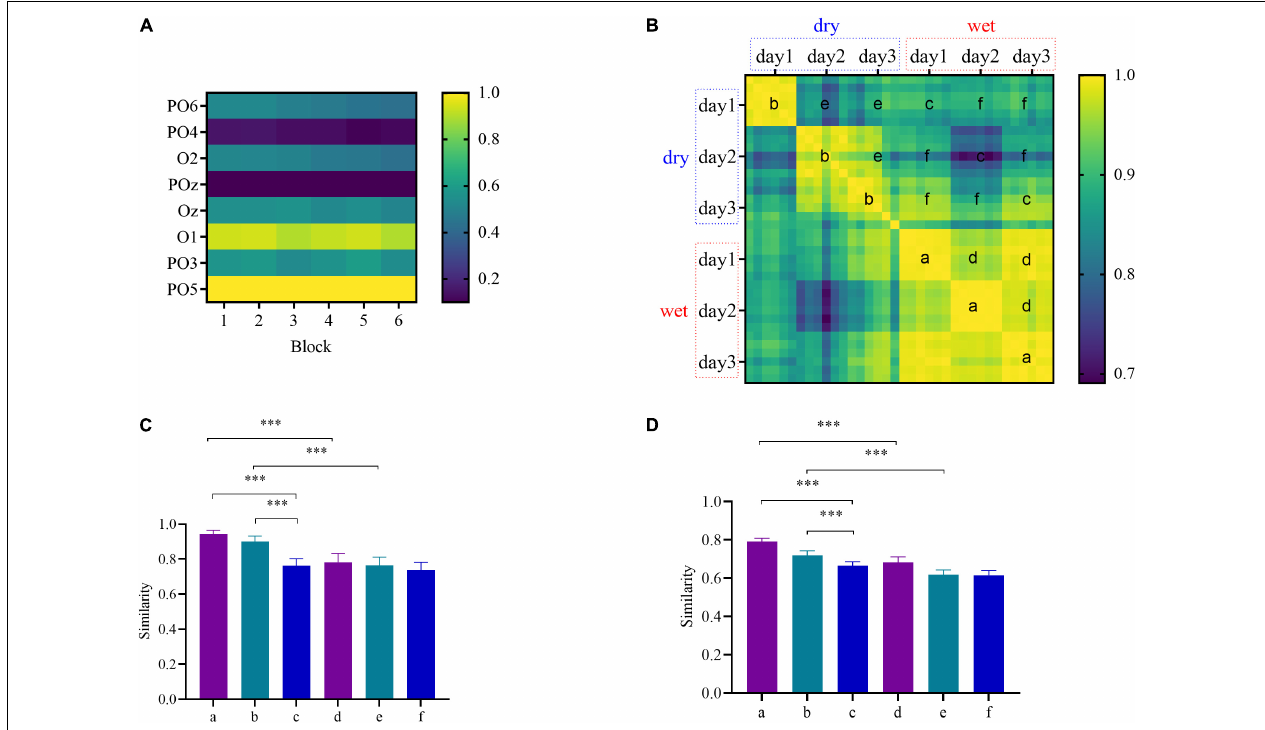
FIGURE 3 | (A) The multi-channel steady-state visual evoked potential (SSVEP) responses over six blocks on day 1 for the wet electrodes of subject S6; the color bar indicates the normalized amplitude. (B) The correlation coefficient matrix between any two blocks of subject S6 for four types; the color bar indicates the similarity. (C) The overall average similarity of the topographical maps of all subjects. (D) The overall average similarity of the covariance matrices of all subjects. The asterisks indicate a difference in the paired t -test results ( ∗ p < 0 . 05, ∗∗ p < 0 . 01, and ∗∗∗ p < 0 .